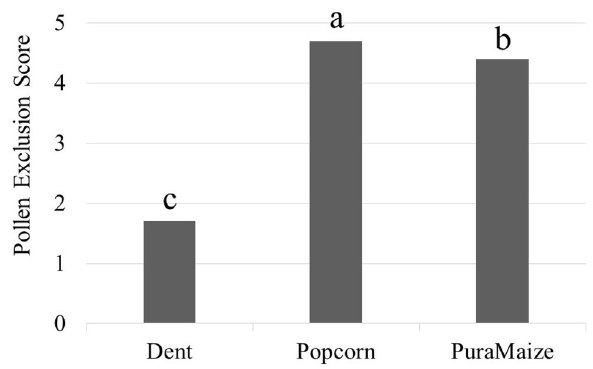
Figure 1. Pollen exclusion ratios of three classes of maize. Classes labelled with different letters are statistically different at p > 0.05.